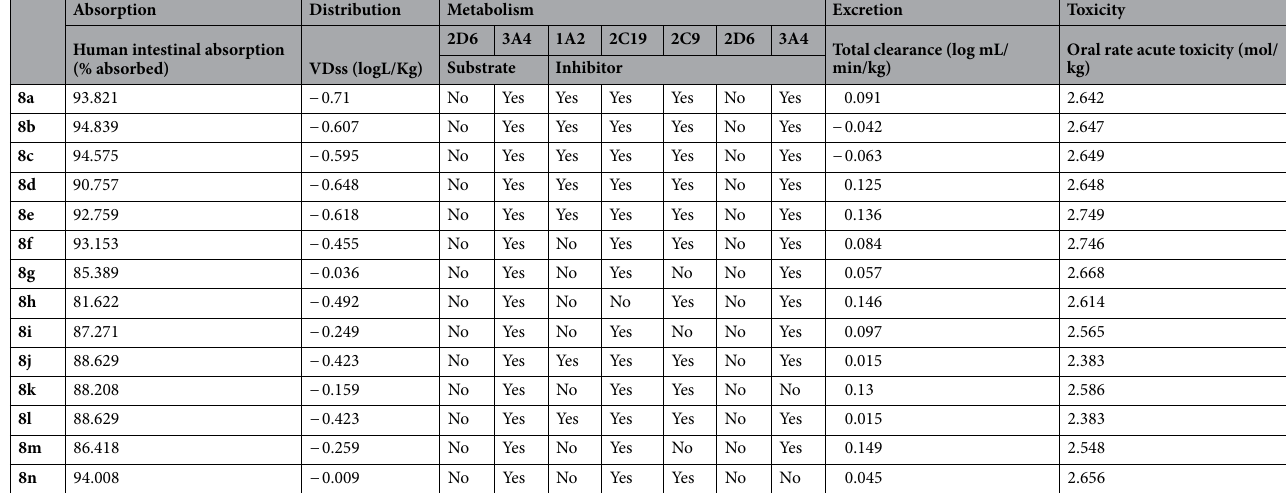
Table 3. ADMET prediction of the synthesized derivatives as urease inhibitors.